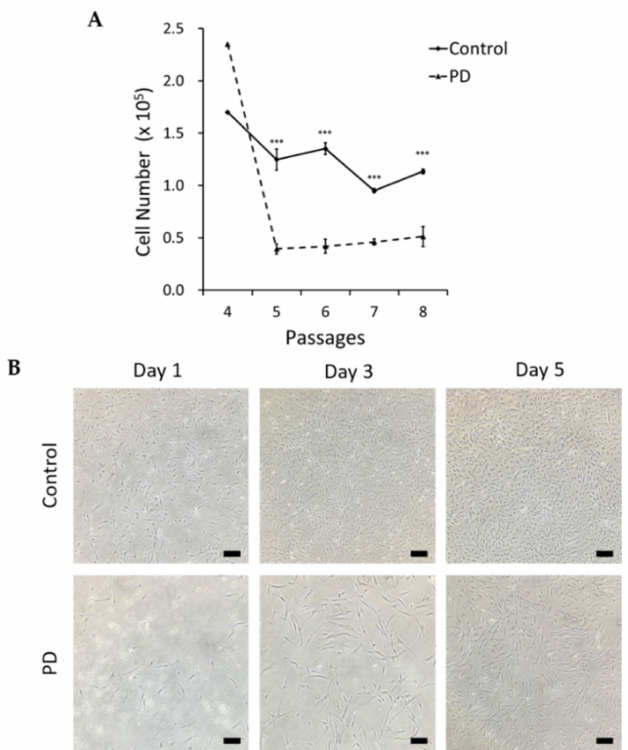
Figure 1. Comparison of cell viability in healthy control and Parkinson’s disease (PD) at each passage. ( A ) Growth curves for mesenchymal stem cells (MSCs) from a PD patient and healthy control at passages 4 to 8. n = 4 for each group. Mean ± S.E.M. ( B ) MSCs from control and PD subjects at